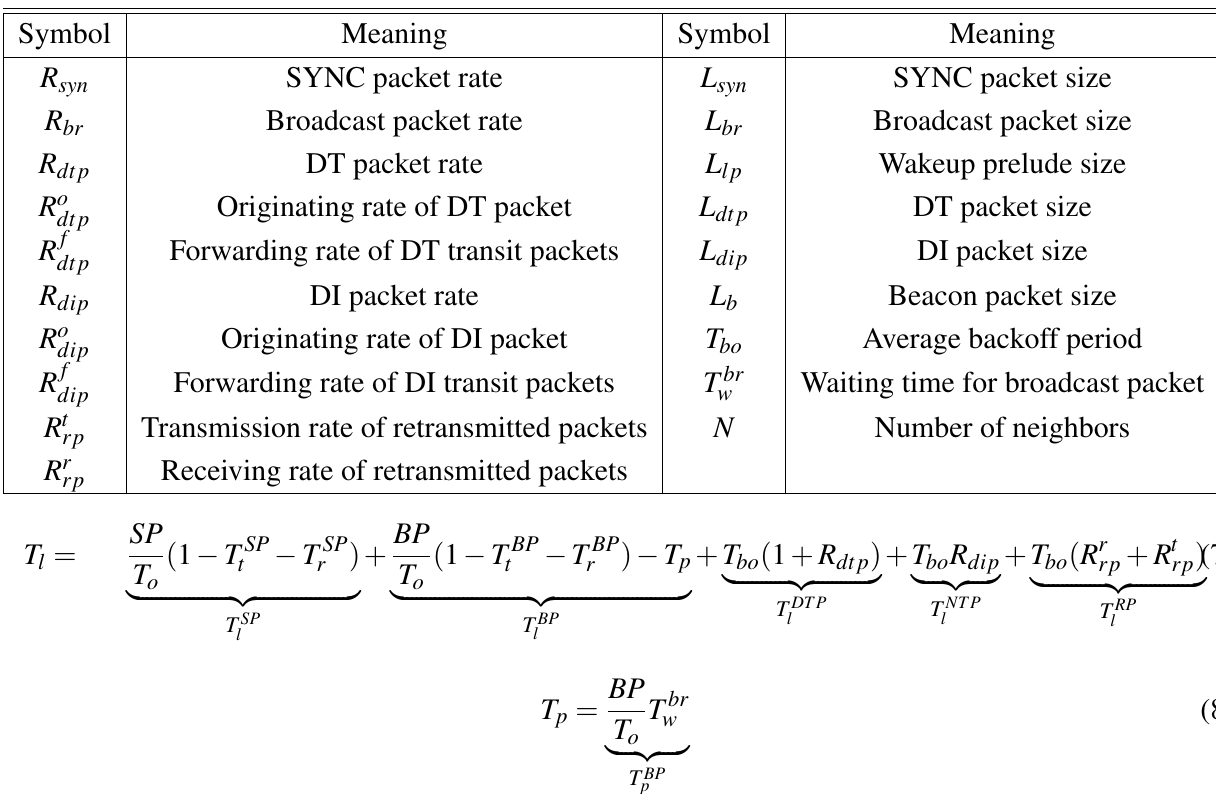
Table 3. Parameters of MQ-MAC in energy